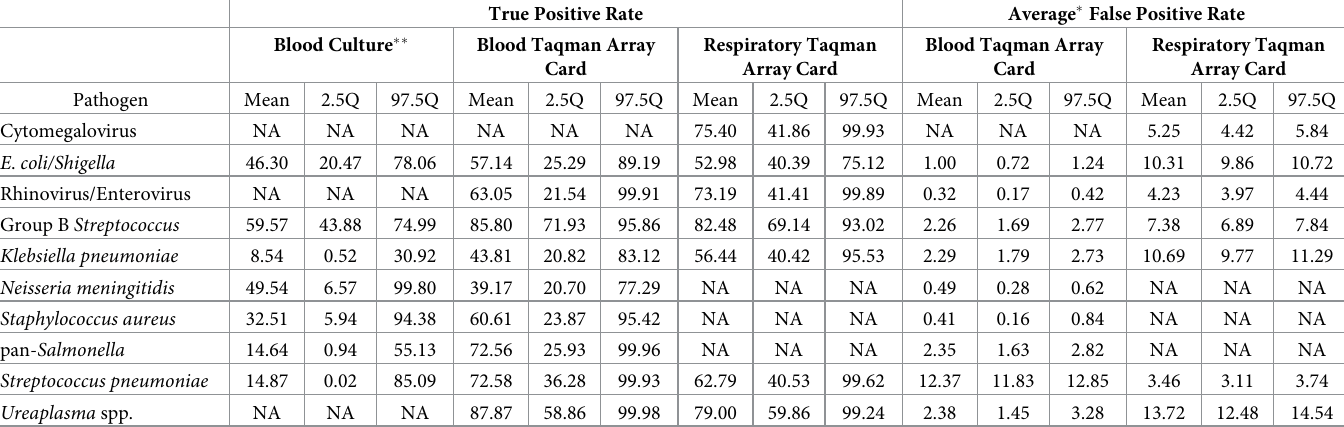
Table 6. Estimated true positive rate (TPR) and average false positive rate (FPR) in percentages by pathogen and testing